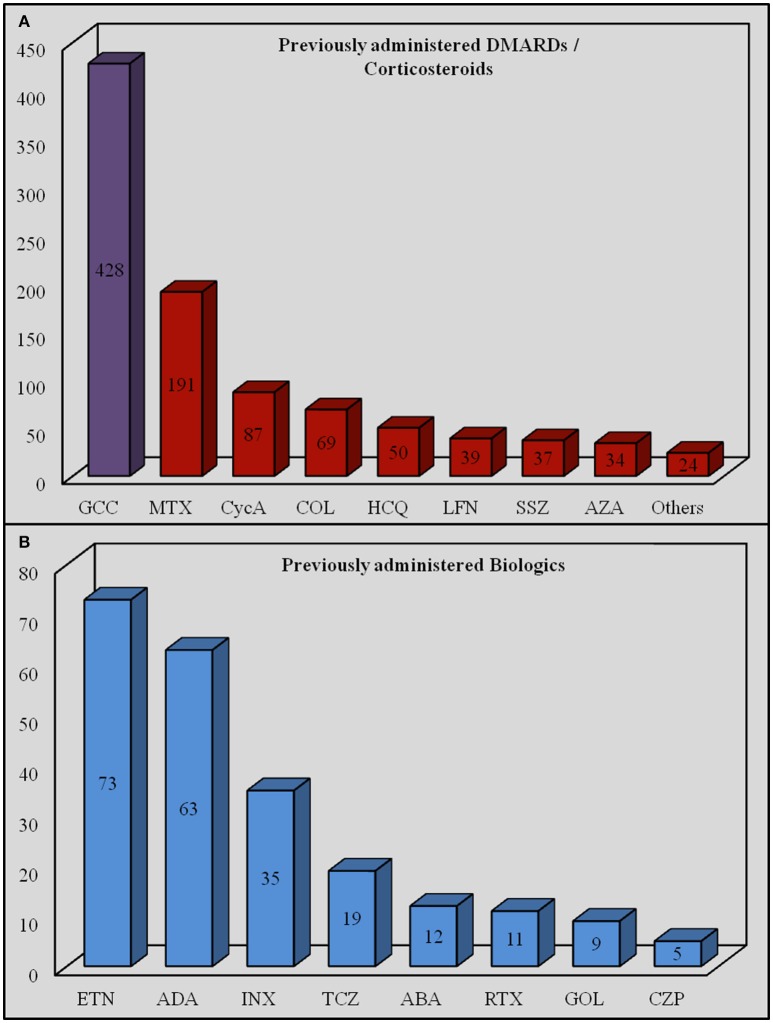
Amount of specific disease modifying antirheumatic drugs/corticosteroids (A) and biologic agents (B) previously administered. ABA, abatacept; ADA, adalimumab; AZA, azathioprine; COL, colchicine; CycA, cyclosporine A; CZP, certolizumab pegol; INX, infliximab; ETN, etanercept; GCC, glucocorticoids; GOL, golimumab; HCQ, hydroxychloroquine; LFN, leflunomide; MTX, methotrexate; RTX, rituximab; SSZ, sulfasalazine; TCZ, tocilizumab.